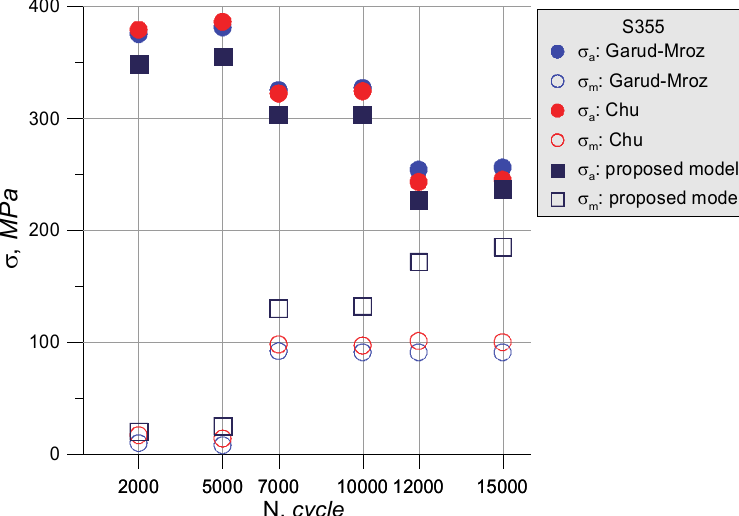
Figure 11: Comparison of the stress history parameters calculated by proposed model and models of Garud-Mroz and Chu for increased mean load value.